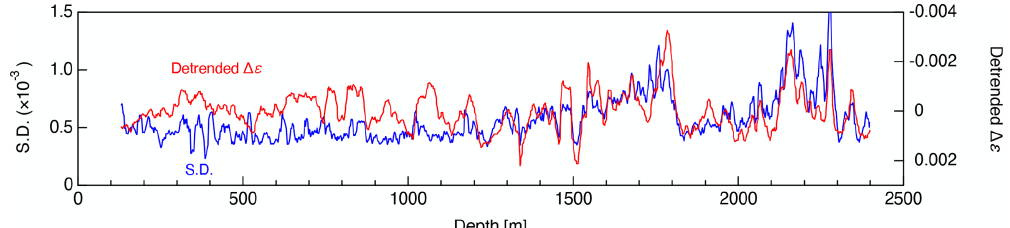
Figure 9. Comparison of the SD values of (cid:49)ε data determined at intervals of approximately 0.5m along the core sample, using approx- imately 23 data points for each interval (blue line) and detrended (cid:49)ε data defined as deviations from the third-order-fitting to the data in Fig. 4a (red lines) (smoothed over 10m intervals). Note that the y axis for the detrended (cid:49)ε has been